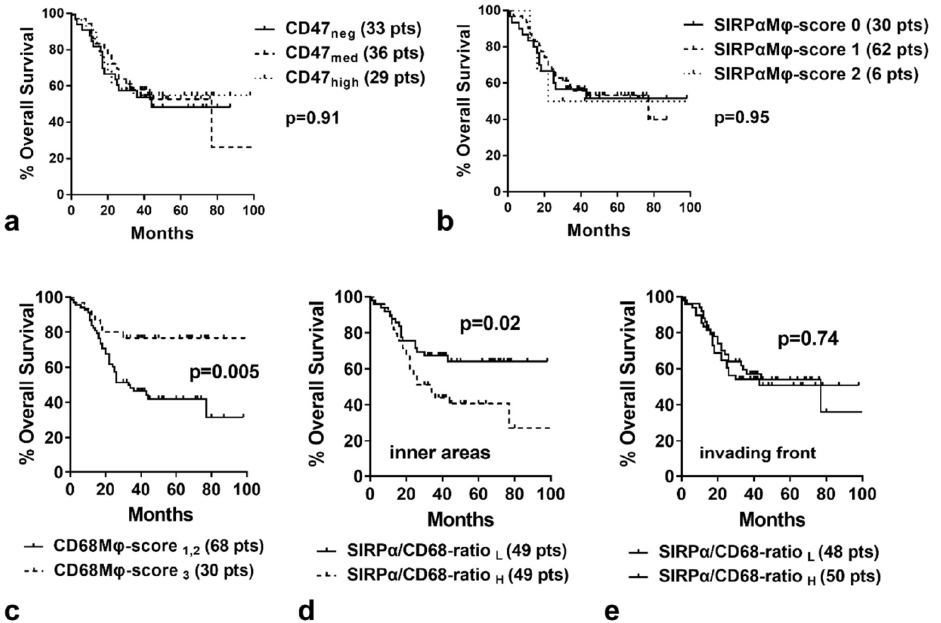
Figure 2. Kaplan–Meier disease-specific overall survival curves stratified for: ( a ) CD47 expression by cancer cells; ( b ) SIRP α -M ϕ score; ( c ) CD68-M ϕ score, ( d ) SIRP α /CD68-ratio in inner tumor areas, and ( e ) SIRP α /CD68-ratio in the invading tumor front (neg = negative, med = medium, pts =